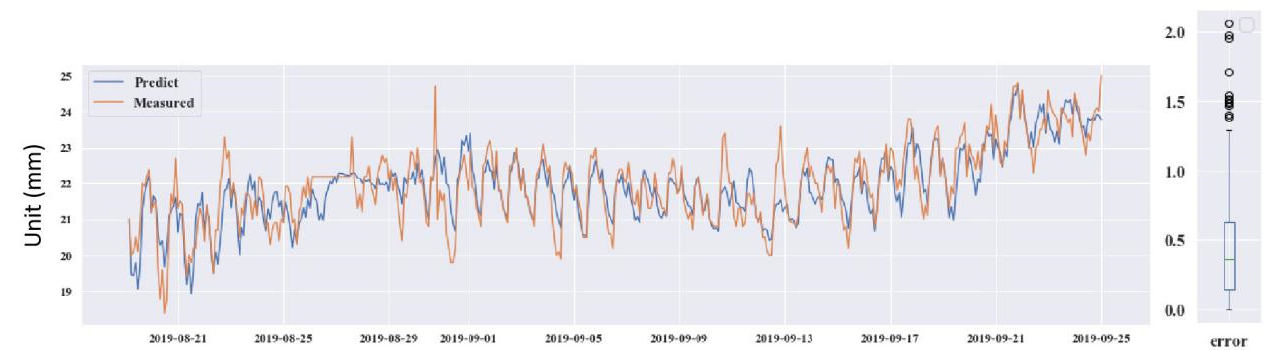
Figure 16. Predicted and measured planar displacement of GPS 14.